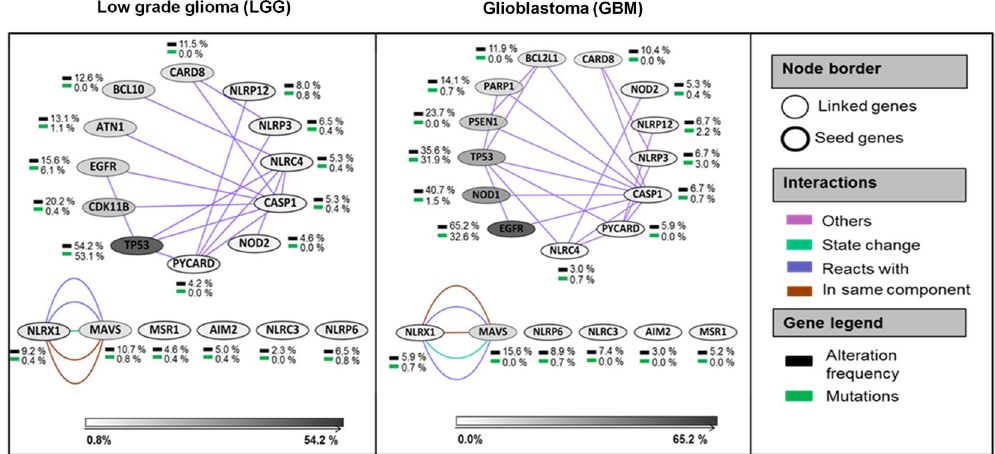
Figure 2. NLR gene expression network in low grade glioma and glioblastoma. Networks for TCGA Low grade glioma (LGG) and Glioblastoma (GBM), were generated using the cBioPortal platform. The edges are color coded by interaction type. Gene legend highlights the frequency of alteration (inclusive of copy number alterations, mutations and mRNA regulation) (black) and mutations (green) with respect to the LGG and GBM associated